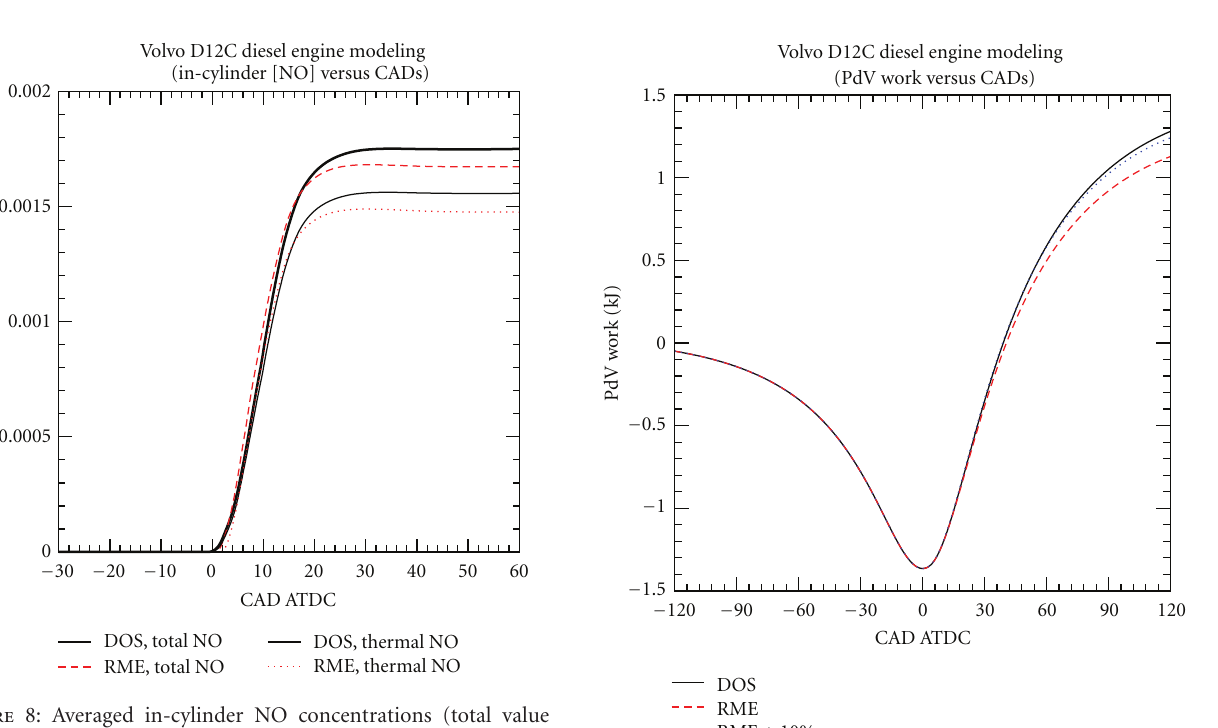
Figure 8: Averaged in-cylinder NO concentrations (total value indicated by bold line, thermal NO by the thin line) for the Volvo D12C diesel engine fuelled by DOS (solid line) and RME (dashed line), without EGR.